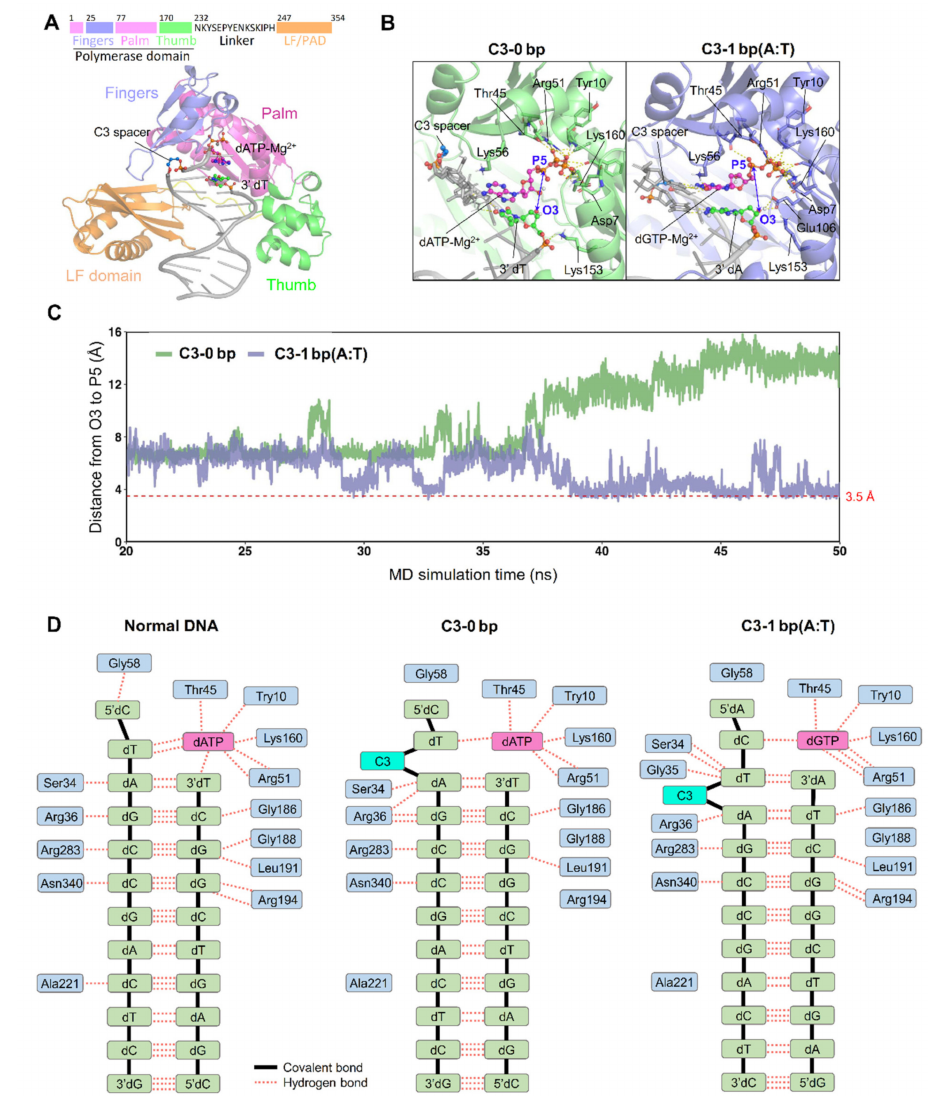
Figure 4. Effect of spacer C3 on TLS efficiency. ( A ) Schematic depiction of the domain composition of Dbh and its modeled structure with bound PT DNA carrying a free spacer C3. ( B ) Modeling of the formation of the phosphodiester bond between the incoming dNTP and the 3 (cid:48) -OH of the primer paired with the DNA template strand with a free (left panel) or bulging (right panel) spacer C3. ( C ) Distance between the 3 (cid:48) -OH of the primer strand and the alpha phosphate group of the incoming dNTP. PT DNA with a free (C3-0 bp) or bulging (C3-1 bp) spacer C3 was used to calculate the distance. ( D ) Hydrogen bond interactions between Dbh and normal PT DNA substrate (left panel) or the counterparts carrying a spacer C3 in the DNA template strand (the middle panel is for free spacer C3, and the right panel is for bulging spacer